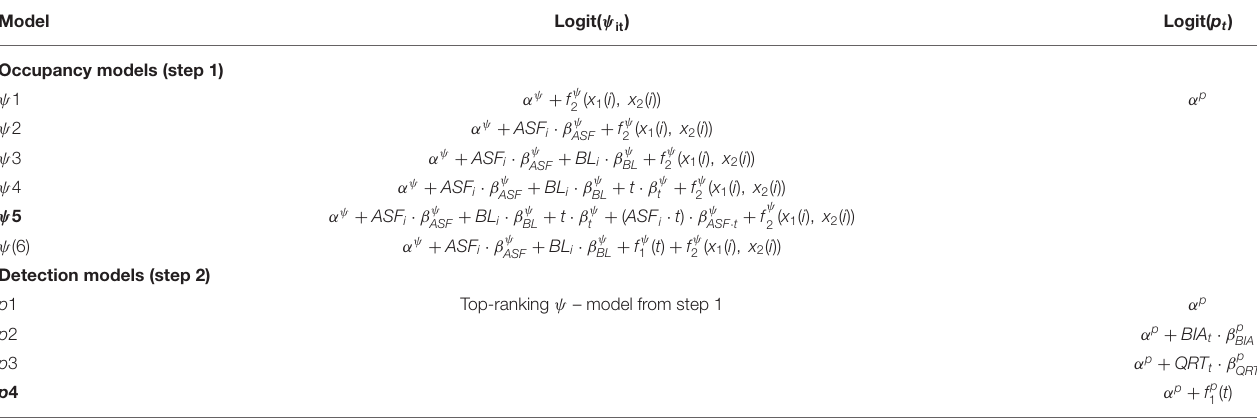
TABLE 1 | A priori defined occupancy (step 1) and detection (step 2) models.